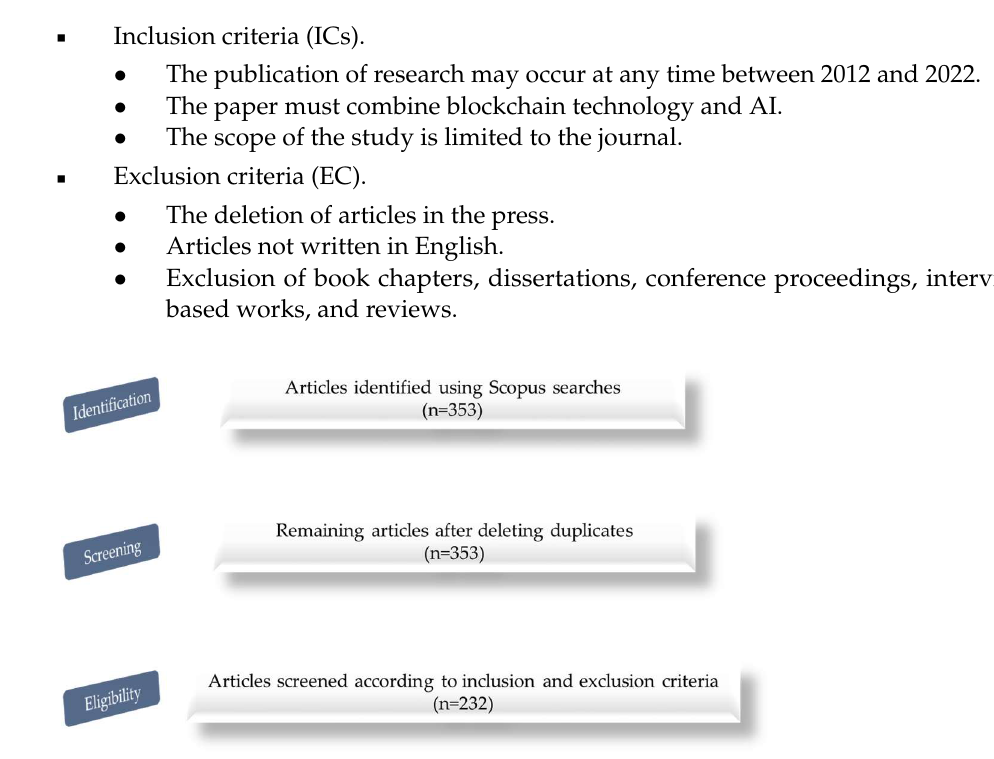
Figure 2. Diagram of research method.